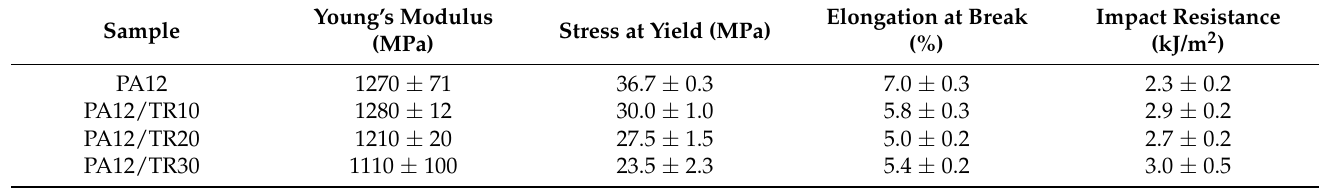
Figure 5. Stress-strain curves of PA12 and PA12/TR samples ( A ) and digital images before and after tensile and impact strength tests ( B ). Table 2. Young’s modulus, elongation at break and impact resistance values of PA12(/TR) printed